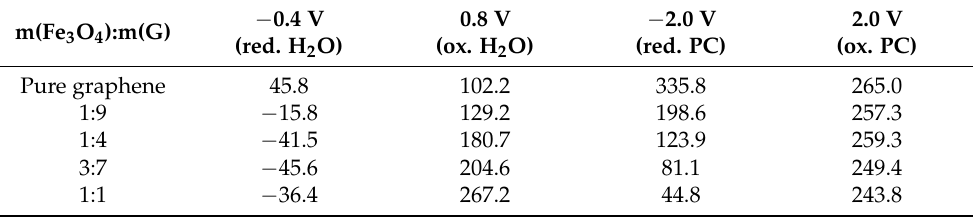
Figure 4. Dependence of QC for pure graphene and G/Fe 3 O 4 membranes with different concentra- tions of magnetite particles on applied voltage. The black dotted line corresponds to 0 V. Table 2. Values of QC for pure graphene and G/Fe 3 O 4 membranes with different concentrations of magnetite particles at the stability limits of electrolyte systems with water and propylene carbonate relative to values at 0 V C Q -C Q